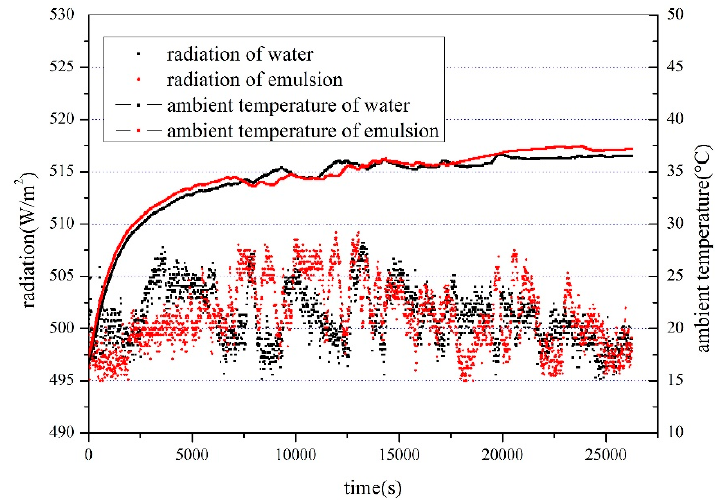
Figure 5. Comparison of ambient temperature and solar radiation.